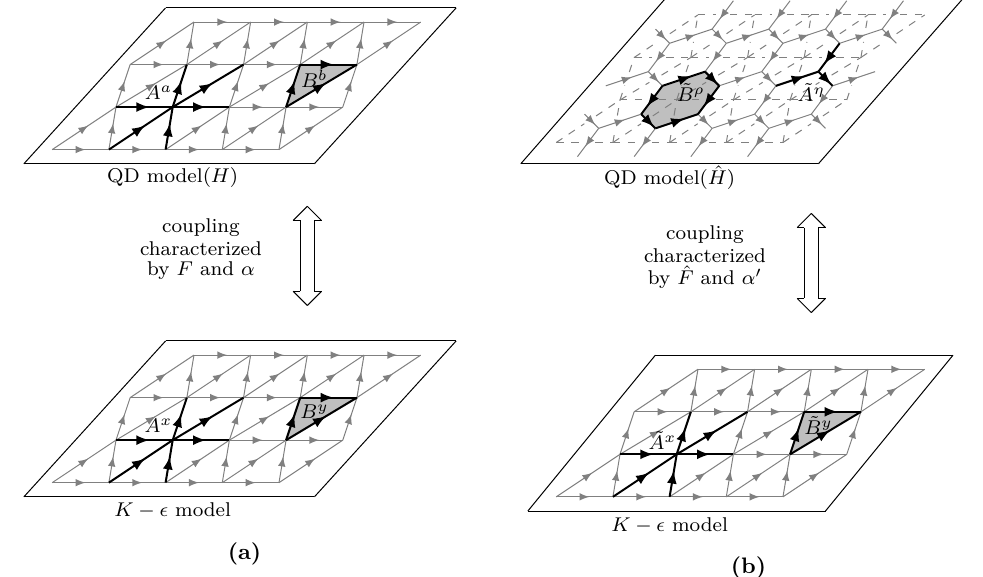
Figure 11 . (a) The TQD ( G, α ) model can be understood as a bilayer system. The upper layer is a QD ( N ) model and the lower layer is a K – (cid:15) model. Both layers are on the same graph. (b) Under the EM duality, the upper layer is mapped to a QD ( ˆ N ) model and K – (cid:15) model on the lower layer remains unchanged. The graphs on the upper and the lower layer is dual to each